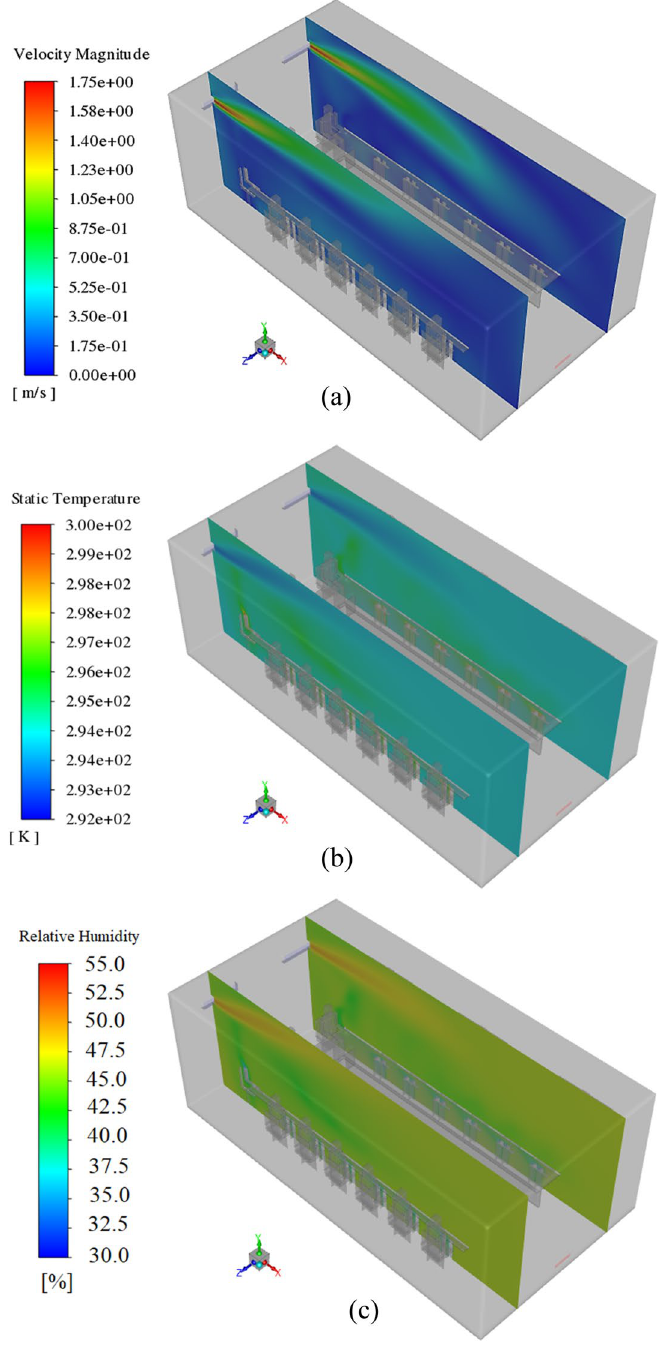
Figure 10. The isometric views of the velocity field, temperature field, and RH variations at Z = 2 and 4.9 m during scenario